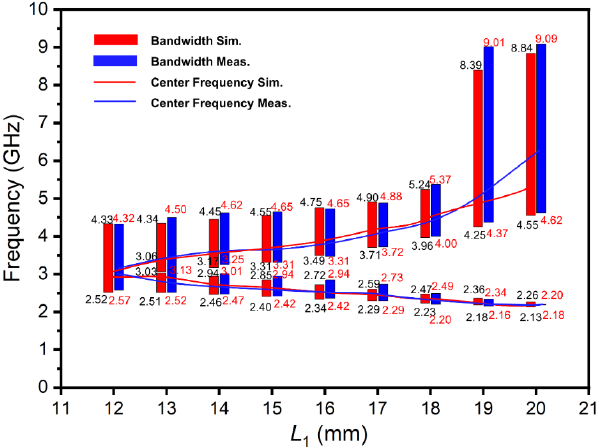
Figure 8. The bandwidth and center frequency of the antenna (the initial condition: L 1 = L 2 = 12 mm). Table 3. The performances of the antenna (the initial condition: L 1 = L 2 = 12